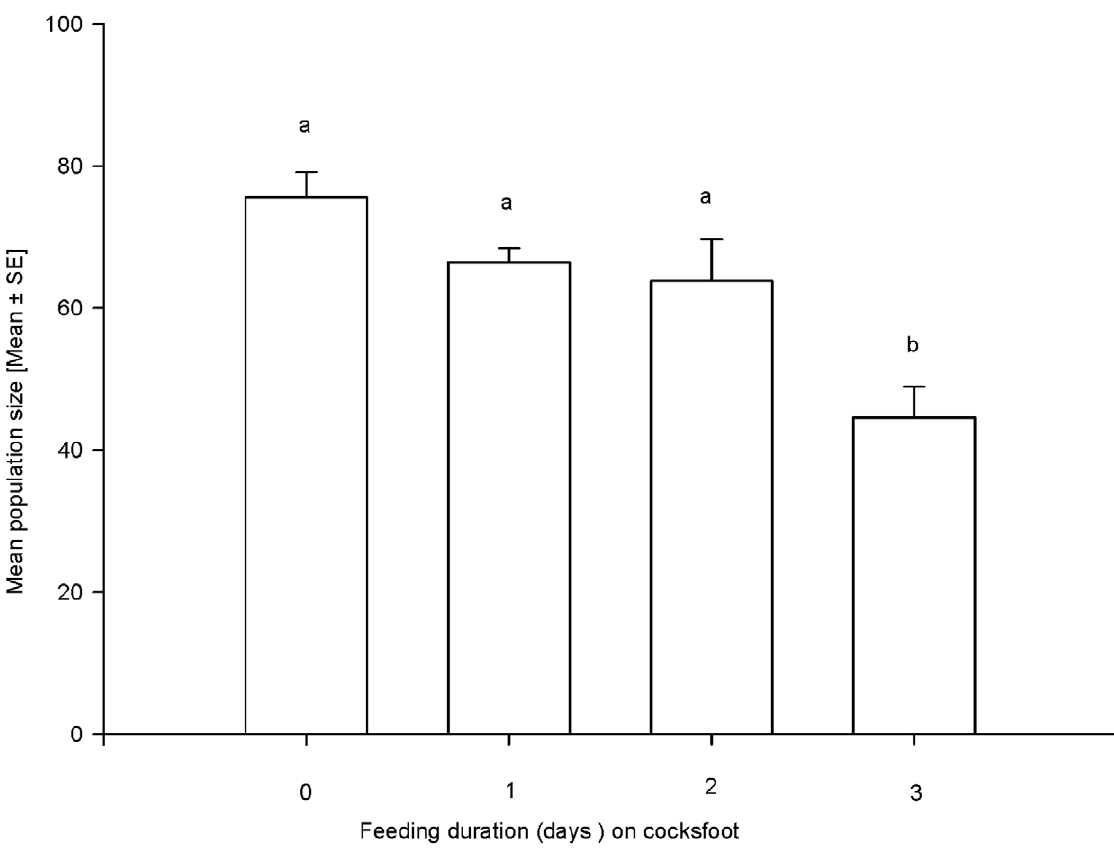
Figure 4. Effect of previous feeding duration on cocksfoot cultivar Amba on the performance of S.avenae clone 5 when transferred to wheat. Nymphs were allowed to feed on Amba for several days prior to transferring them to wheat (F 3,36 =9,91, P , 0.001; R 2 =0.45).